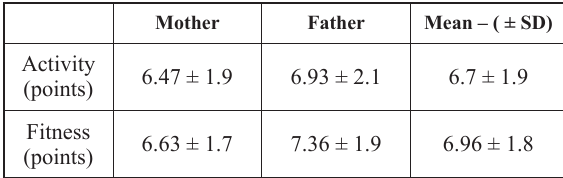
Table 4. Parents’ physical activity and physical fitness test scores (means) Mother Father Mean – ( ± SD) Activity 6.47 ± 1.9 6.93 ± 2.1 6.7 ± 1.9 (points) Fitness 6.63 ± 1.7 7.36 ± 1.9 6.96 ± 1.8 (points) Note: x ± SN – mean and standard